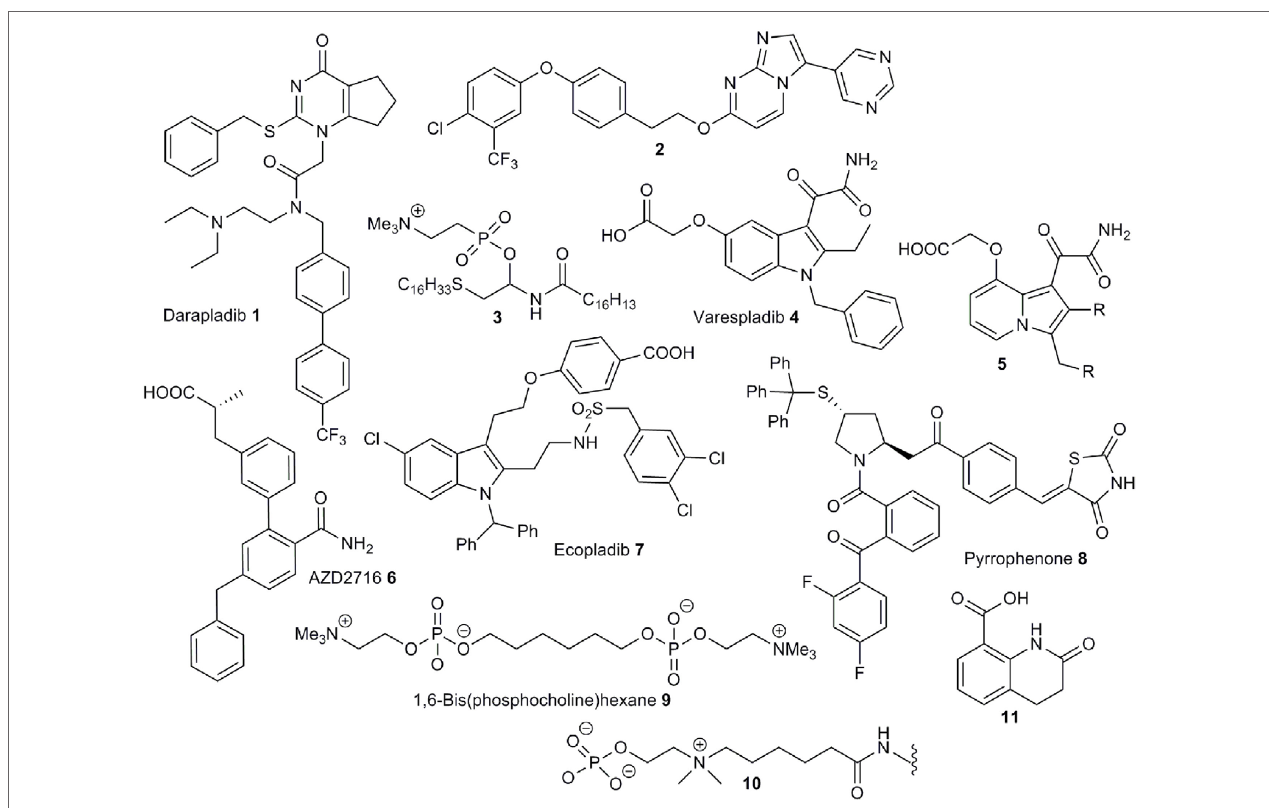
FigURe 2 | Example structures of anti-PLA 2 drugs and small-molecule binders to